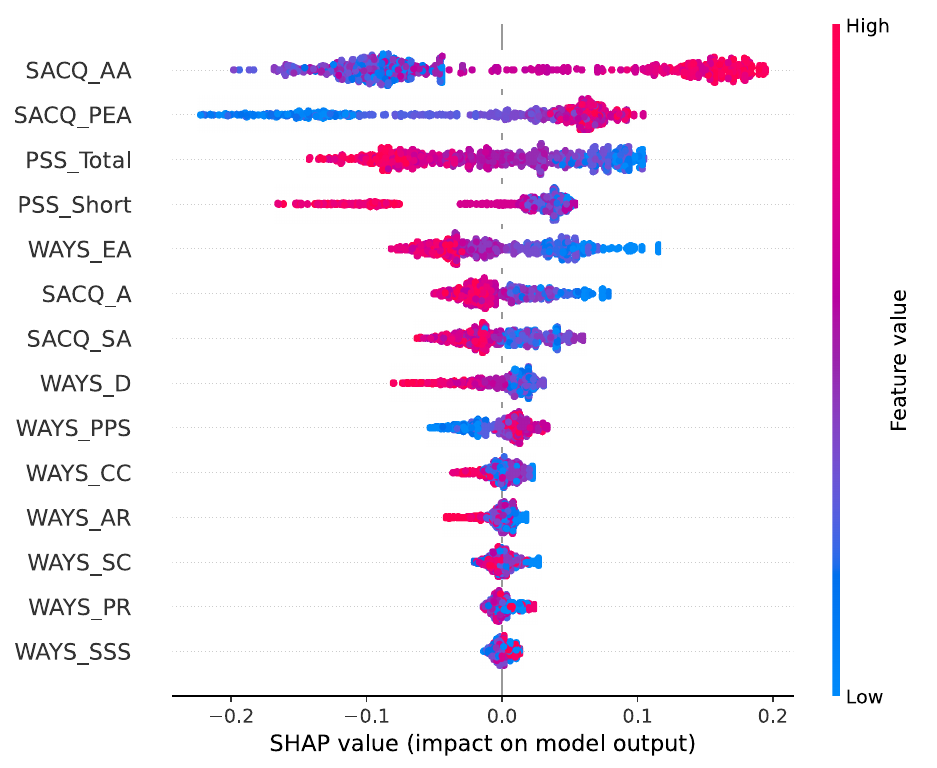
Fig 2. SHAP plot for academic adjustment using the random forest